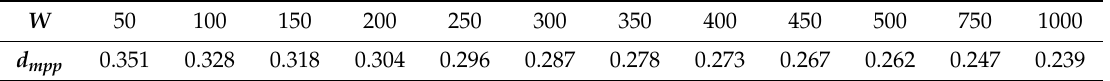
Table 1. Duty cycle ratio at MPPT conditions ( d mpp ) corresponding to each Irradiation (W, @ 25 °C).